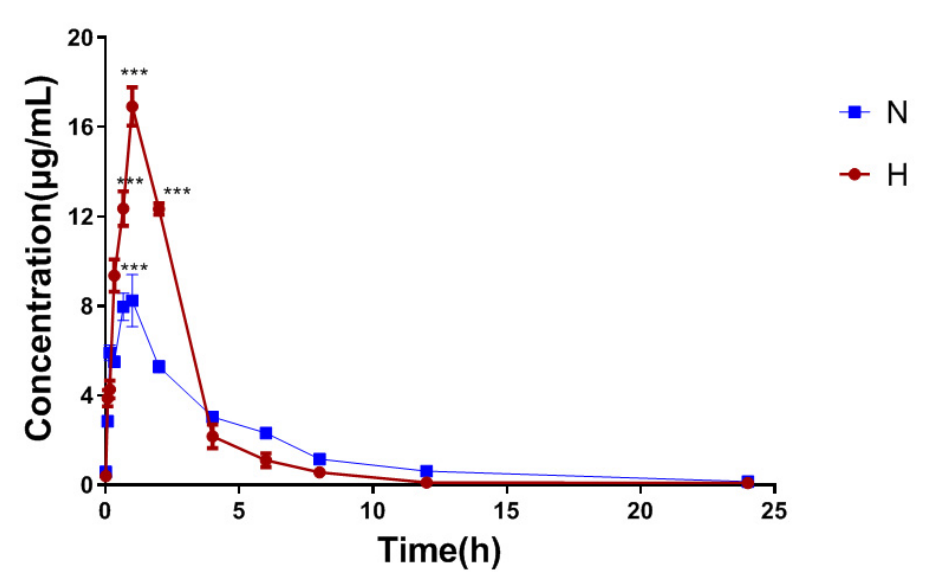
Figure 4. Mean plasma concentration-time curves of acipimox in rats with and without hypoxia following intragastric administration to rats ( n = 6 ). N: Normoxia; H: Hypoxia; *** p < 0.001. Table 6. Pharmacokinetic parameters of acipimox to rats with and without hypoxia. ( n = 6 ).